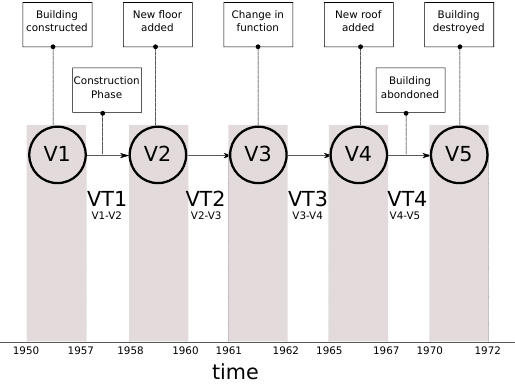
Figure 1. Versions and Version Transitions